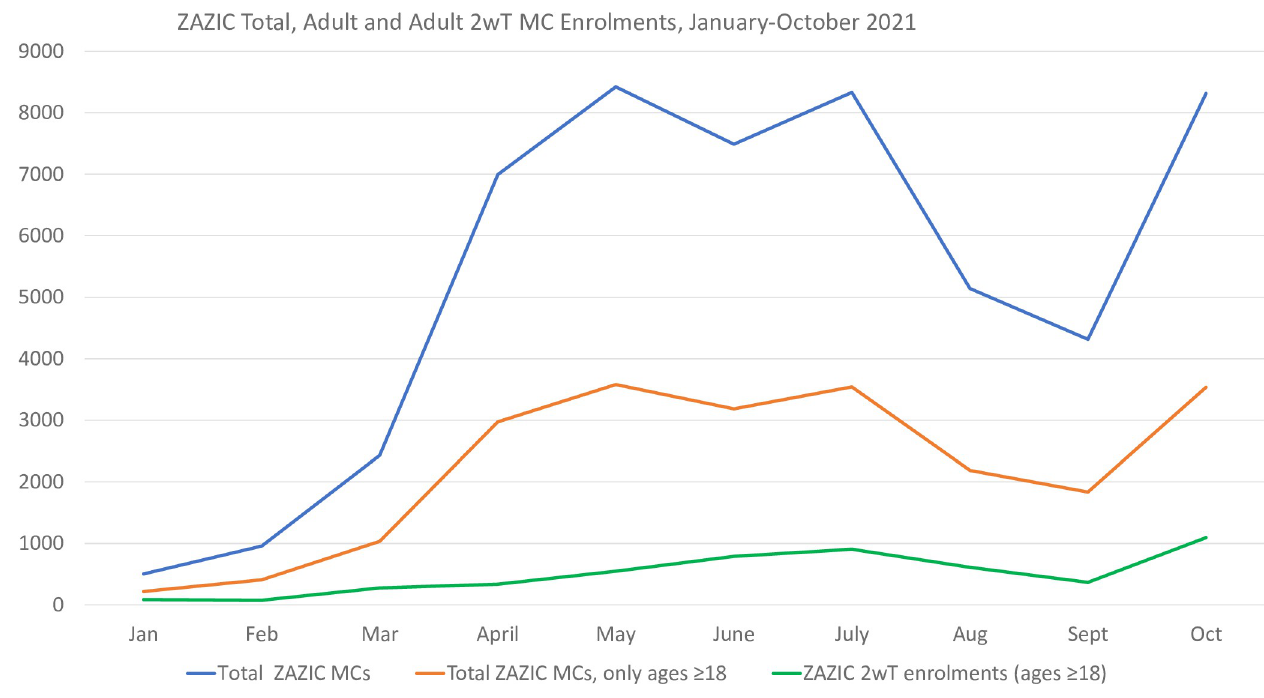
Fig 6. ZAZIC MC enrolments January 2021-October 2021, by: total MCs (ages � 15), adult MCs (ages � 18), and 2wT enrolments (ages � 18).